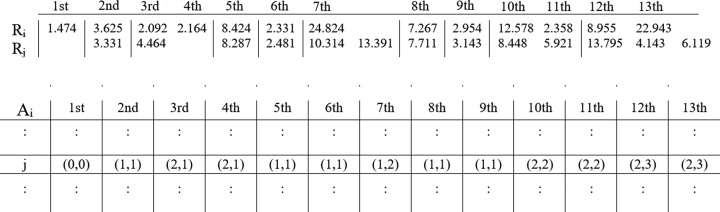
An alignment between Ri and Rj as given by Valouev et al. [14] and its corresponding entry in the multiple alignment grid \documentclass[12pt]{minimal}
\usepackage{amsmath}
\usepackage{wasysym}
\usepackage{amsfonts}
\usepackage{amssymb}
\usepackage{amsbsy}
\usepackage{upgreek}
\usepackage{mathrsfs}
\setlength{\oddsidemargin}{-69pt}
\begin{document}
}{}$\mathsf {A}_i$\end{document}. Each column of \documentclass[12pt]{minimal}
\usepackage{amsmath}
\usepackage{wasysym}
\usepackage{amsfonts}
\usepackage{amssymb}
\usepackage{amsbsy}
\usepackage{upgreek}
\usepackage{mathrsfs}
\setlength{\oddsidemargin}{-69pt}
\begin{document}
}{}$\mathsf {A}_i$\end{document} represents one fragment from Ri, and each row represents one Rmap from its set of related Rmaps. The fragment sizes are in Kbp.